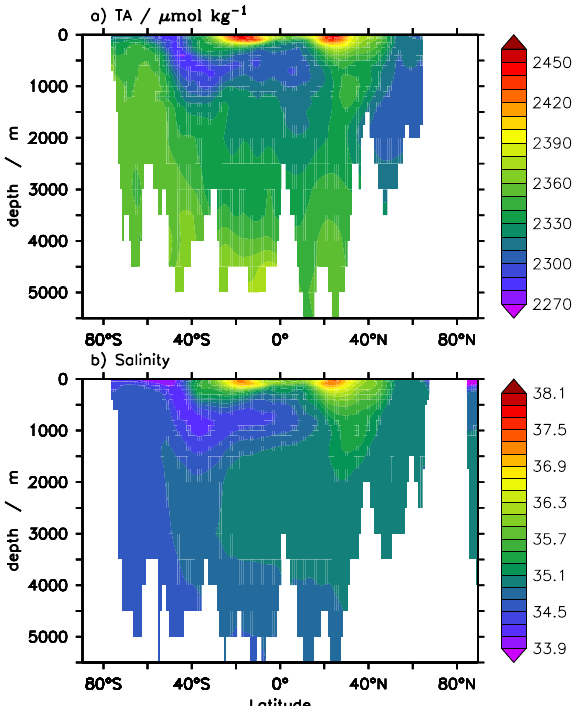
Figure 4. Distribution of total alkalinity (a) and a preformed alka- linity tracer (b) along 30 ◦ W from a model run (TMM-MIT28, see Sect. 4 for details of the model experiments). The r 2 of (a) over (b) is 0.631. The preformed alkalinity (TA 0 ) tracer is restored at the surface and at any time step of the model run to total alkalinity. In the interior of the model ocean TA 0 has no biogeochemical sources or sinks but is advected and mixed conservatively. TA in this model is affected by both physical and biogeochemical